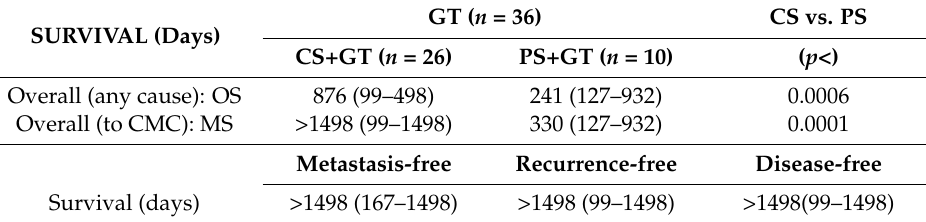
Table 3. Median overall and disease-free survivals obtained from Kaplan–Meier data (Figure